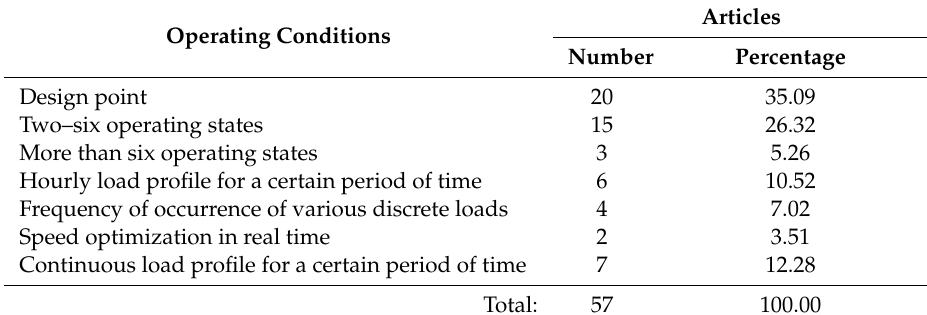
Table 3. Consideration of operating conditions in optimization and number of